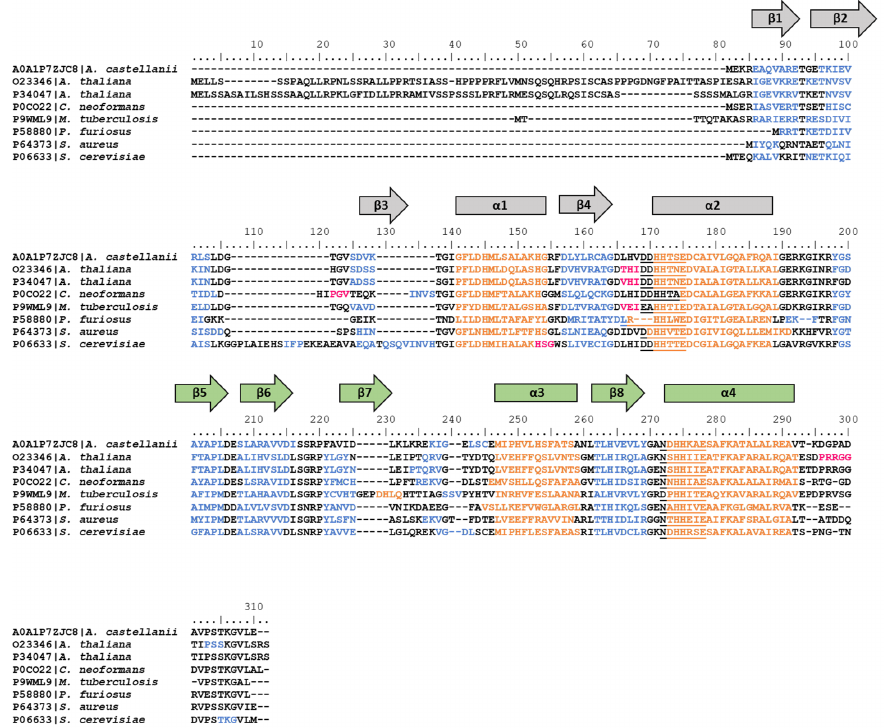
Figure 8. Alignment of the amino acid sequences of IGPDs reported in the PDB. Secondary structure elements are reported in orange ( α -helices), blue ( β -strands), and fuchsia (turns). The (D/N)XHHXXE motifs are underlined. α -helices and β -strands are also schematized with rectangles and arrows, respectively; the elongation event is depicted with the two halves of the proteins colored in grey and green.